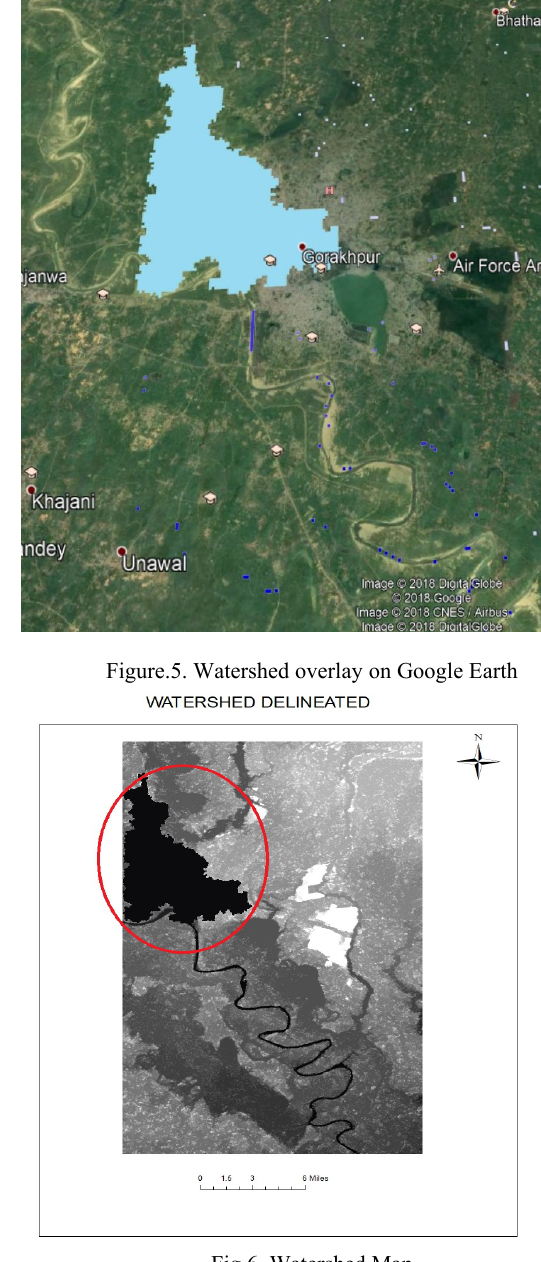
Fig.6. Watershed